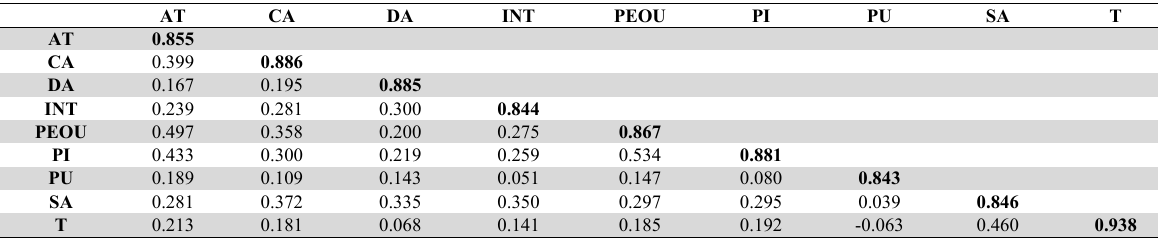
Fornell-Larcker Criterion Results AT